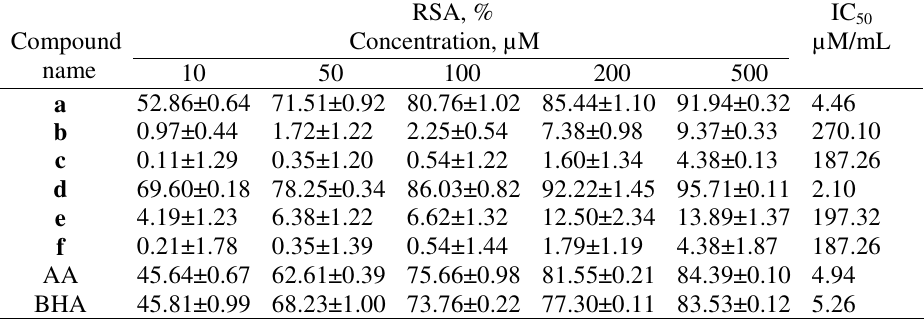
β -Carotene- linoleic acid model